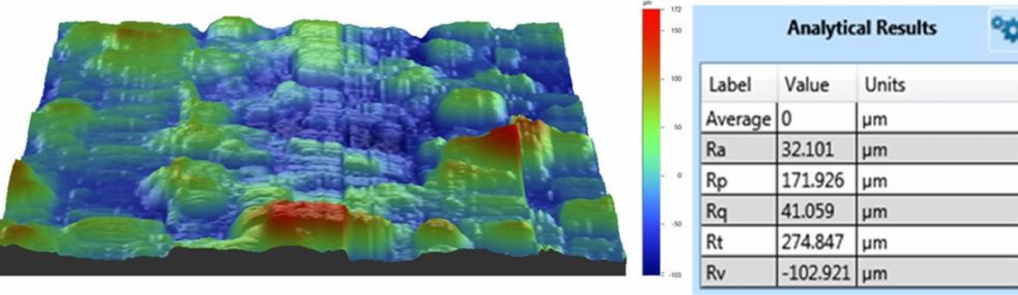
Figure 3. Roughness of the Ti/Ti/HA coating.